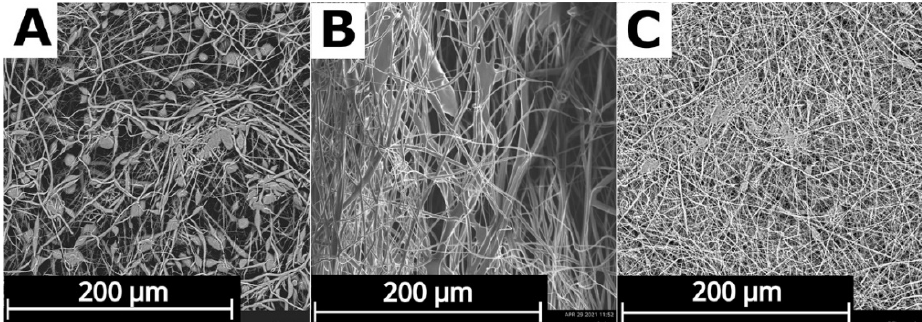
Figure 1. Structures of polycaprolactone substrates from different solvents ( A ) acetone (PCL_AC), ( B ) chloroform + ethanol (PCL_CHE), and ( C ) acetic acid (PCL_AA). Scanning electron microscope (SEM) analysis.